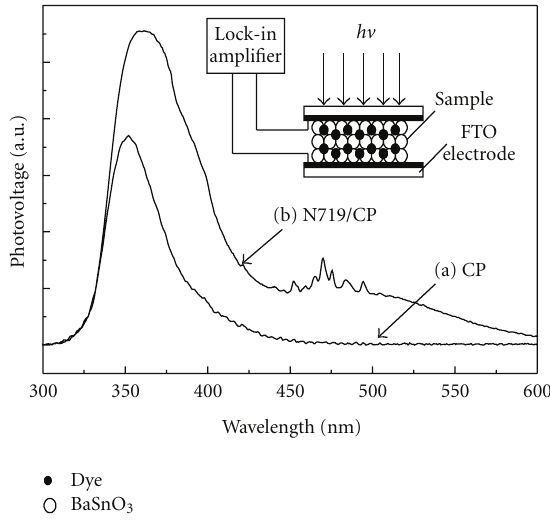
Figure 6: Surface photovoltage spectra of CP (curve a) and N719/CP samples (curve b). Inset: a schematic diagram of a photovoltage measurement.